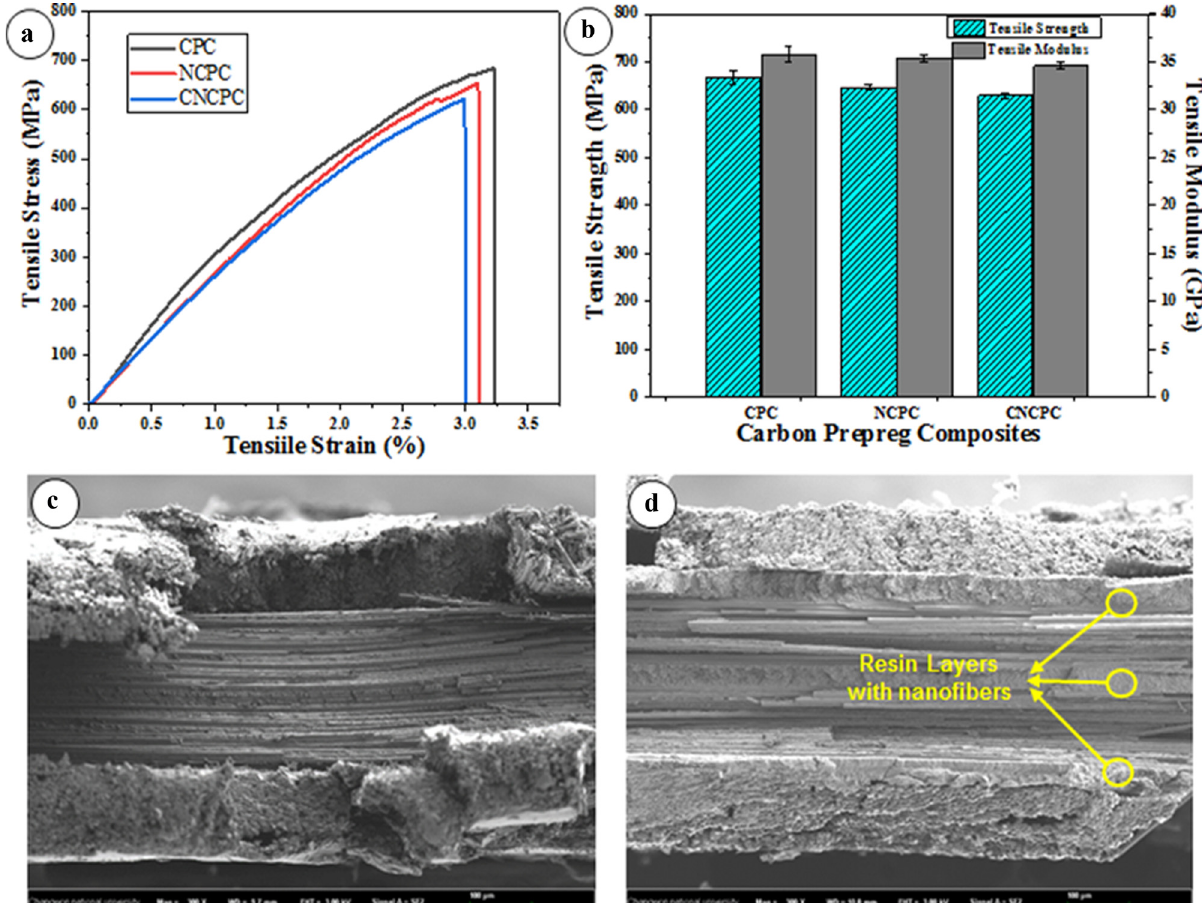
Figure 2: ( a and b ) Tensile test results of CPC, NCPC, and CNCPC composites, and ( c and d ) fracture SEM images of CPC and NCPC